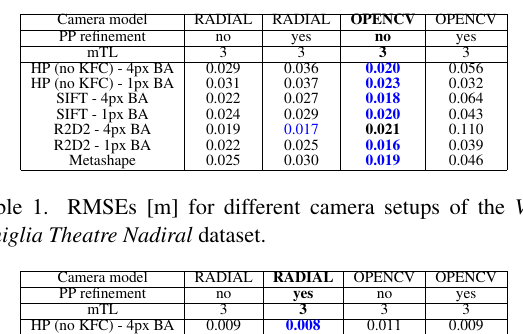
Tables 1-5 show the preliminary analysis for selecting the most appropriate camera model (RADIAL or OPENCV) on each dataset according to the image network. Only a meaningful sub- set of the image matching methods was employed: HP without KFC, SIFT, Metashape and R2D2 (which often provides worse results). For all methods the maximum reprojection error in the BA was set to 4 px (COLMAP default) and 1 px. The column corresponding to the selected camera setup is highlighted in bold, while the best setup for each method in blue. It can be clearly noted that the choice of the camera setup is not trivial for some datasets.